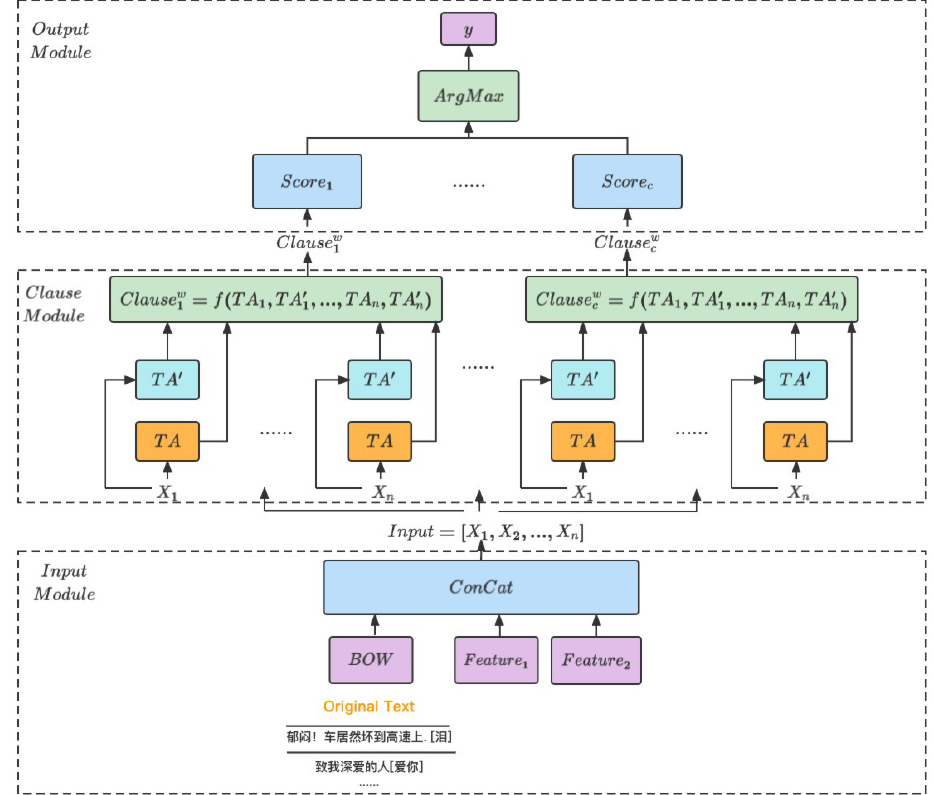
Figure 1. The Architecture of TM. In the Input Module, BOW means one-hot vector from bag of words and Feature means external features. We used a dotted line to frame the Feature extraction process in the Input Module to indicate that this step was optional. In the TA Module, we calculated the output of clause by function f ( · ) . Parameter c and class were set manually. One was the clauses number and the other was the classes number. Function Score i sums all outputs of clauses for the target